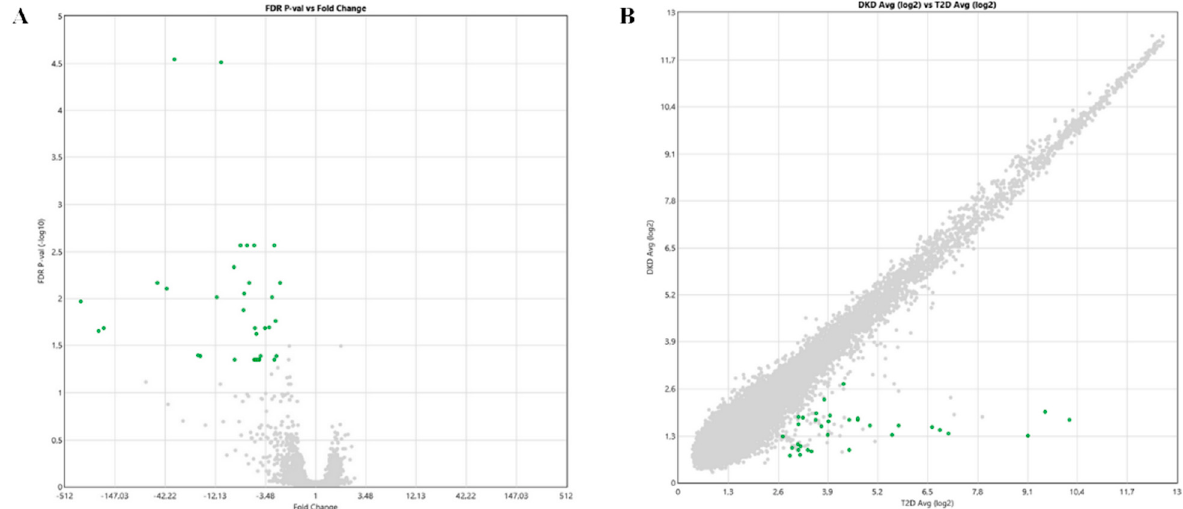
Figure 1. Volcano ( A ) and scatter plots ( B ) assessing the variation between diabetic patients with or without Diabetic Kidney Disease (DKD). The volcano plot visualizes the base 10 negative logarithm of the FDR-corrected p -values (Y-axis) and fold-change deregulation values (X-axis) ( A ). In the scatter plot, the values plotted on the X and Y axis are the averaged normalized signal values in each group (log 2 scaled) ( B ). In both panels, green points indicate > 2.0-fold down-regulation of expression and grey points indicate < 2.0-fold-change in expression. FDR-corrected p -value < 0.05.